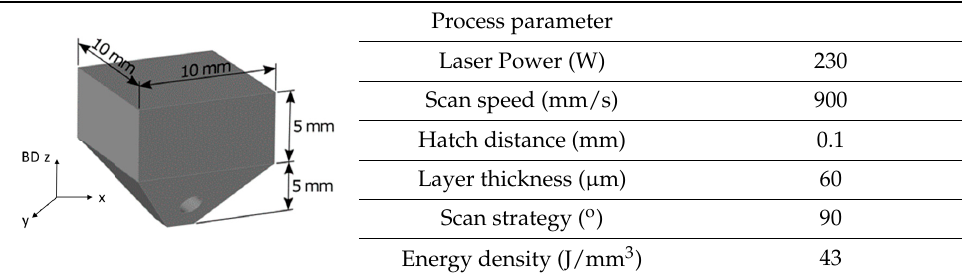
Table 3. Sample dimensions and LPBF process parameters.